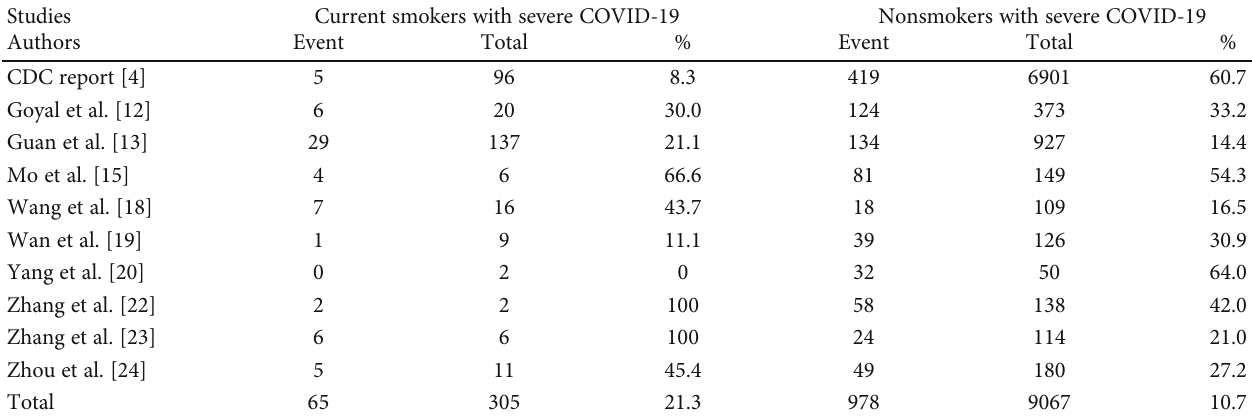
Table 4: The relationship between smoking status and the severe